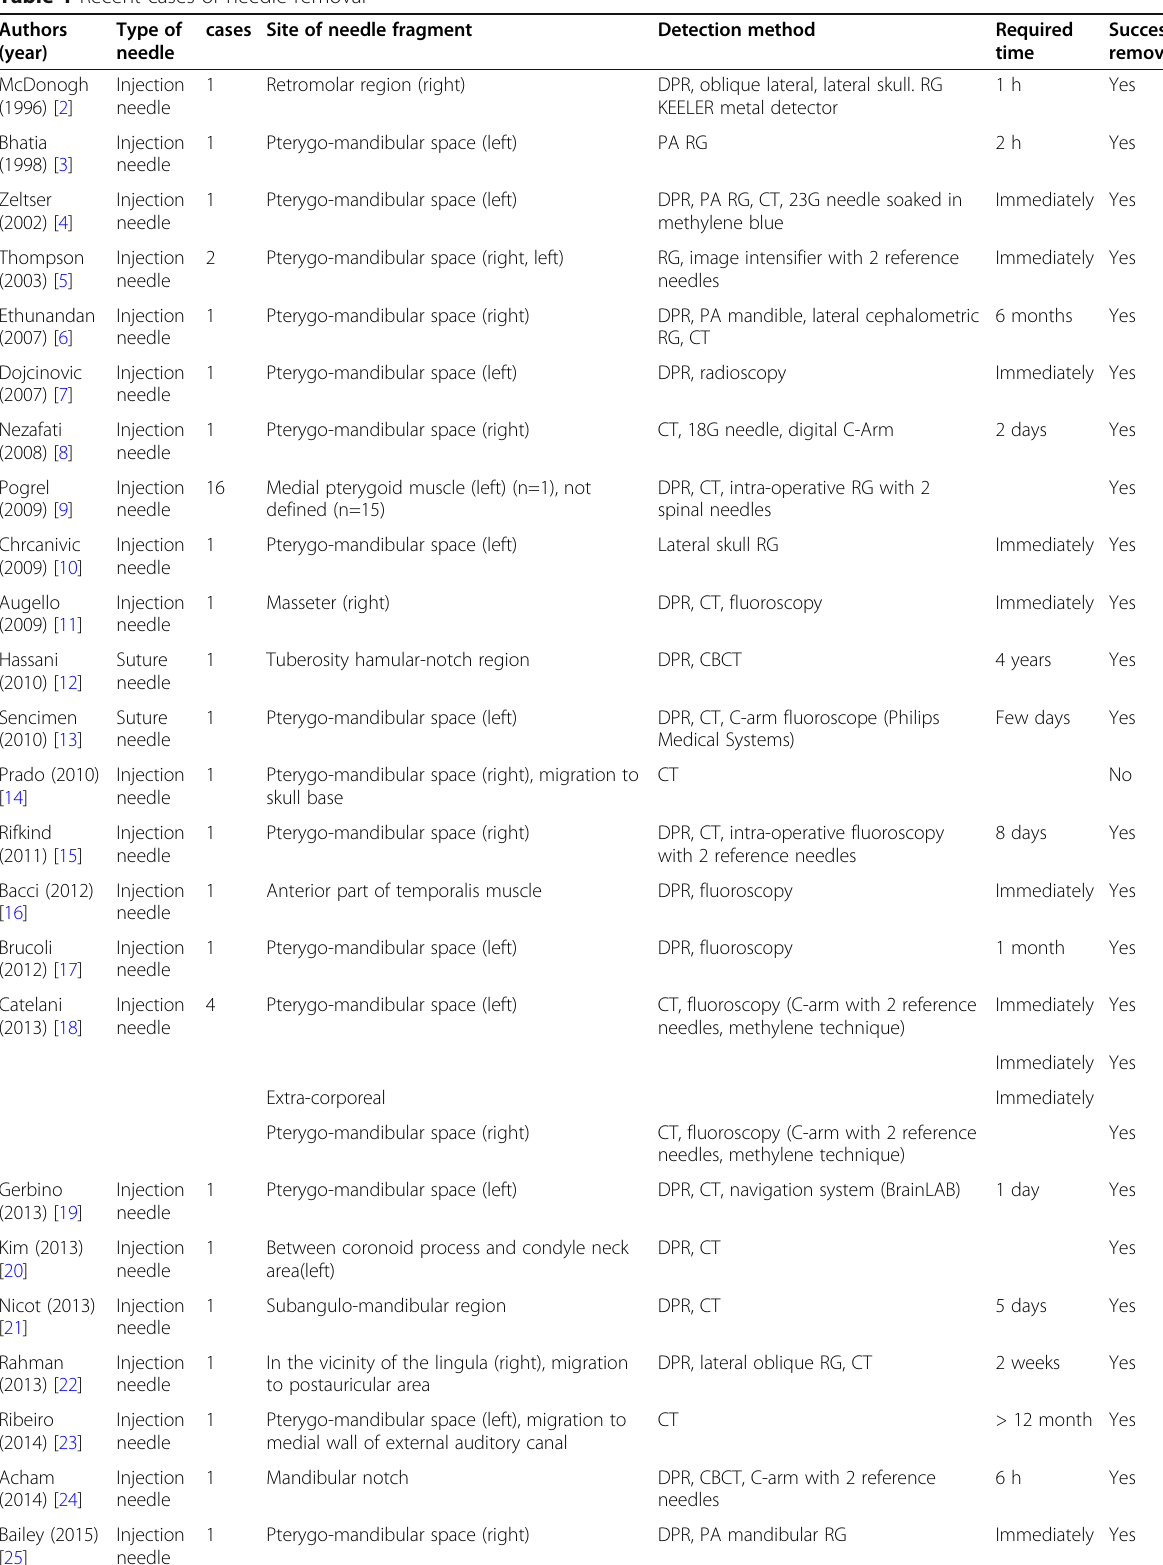
Table 1 Recent cases of needle